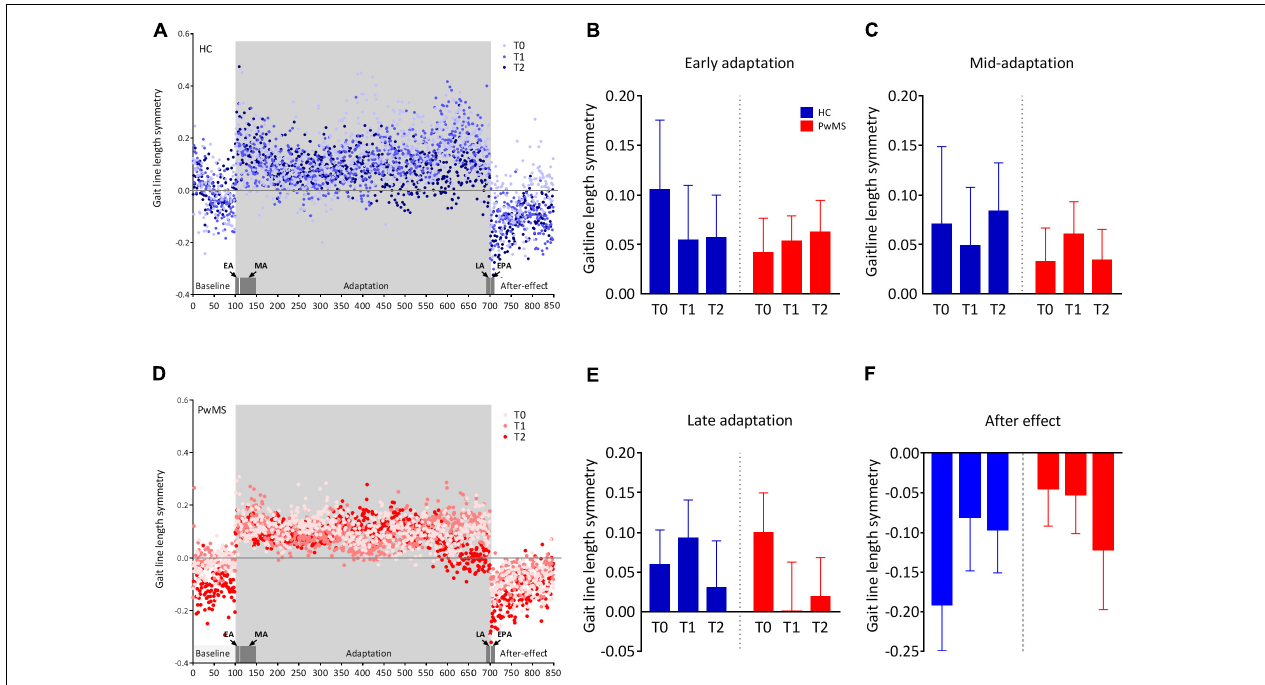
FIGURE 2 | Changes in the symmetry of gaitline length across training phases in experiment 1 (training without tDCS): (A,D) The changes in the mean gaitline symmetry for each training phase are illustrated with respect to the stride number for healthy controls (HC) and people with multiple sclerosis (PwMS). The first and last six strides of the adaptation period define the early , EA and the late adaptation, LA, respectively. The first six strides of the postadaptation period are called early postadaptation , EPA and the mid-adaptation , MA is the average of the 50 strides following EA. Dots represent the means of the calculated gaitline symmetry at each stride for the entire group (HC or PwMS). Training on the split-belt treadmill was performed at T0, T1 (24 h after the first trial) and T2 (72 h after the first trial). The blue color represents data from HC and red dots are data obtained from PwMS. (B) Average gaitline length symmetry in the early adaptation obtained from the first six strides in the adaptation phase. (C) Average gaitline length symmetry during mid-adaptation obtained from the first 50 strides following early adaptation in the adaptation phase. (E) Average gaitline length symmetry during late adaptation obtained from the last six strides in the adaptation phase. (F) Average gaitline length symmetry during early postadaptation obtained from the first six strides in the postadaptation phase of the training. Error bars represent the standard error of means (sem, N = 10 per